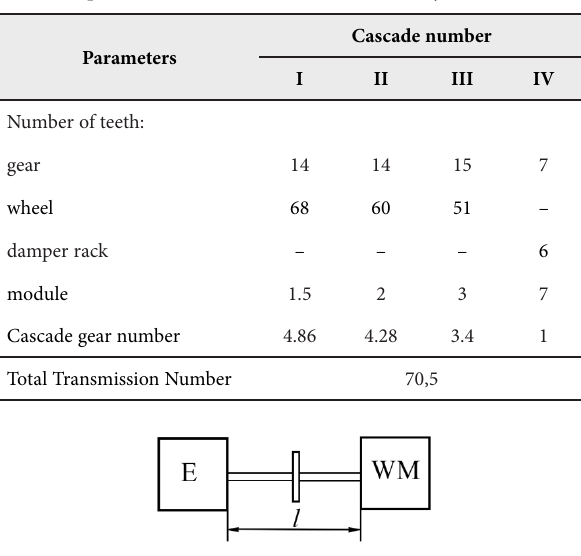
Fig. 2. Connection of engine and working machine